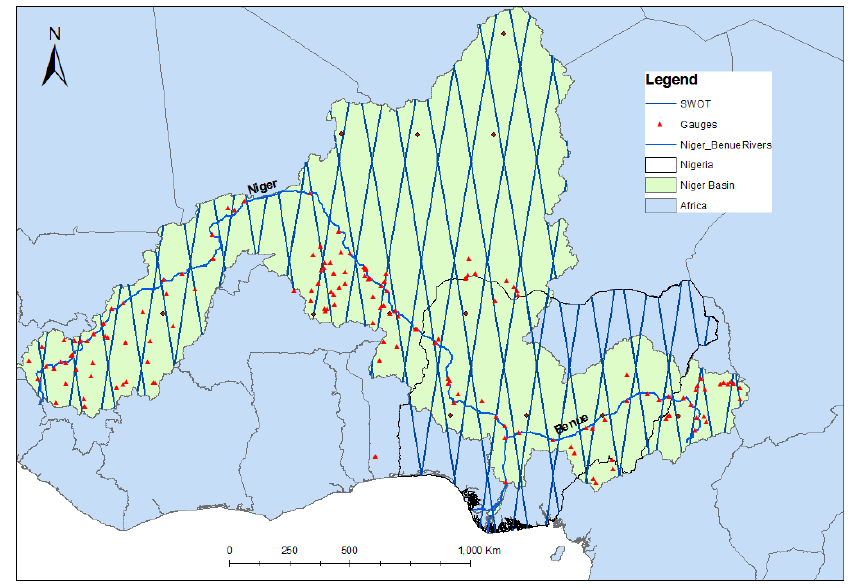
Figure 14. SWOT Altimetry Tracks within the Niger River Basin of West Africa.